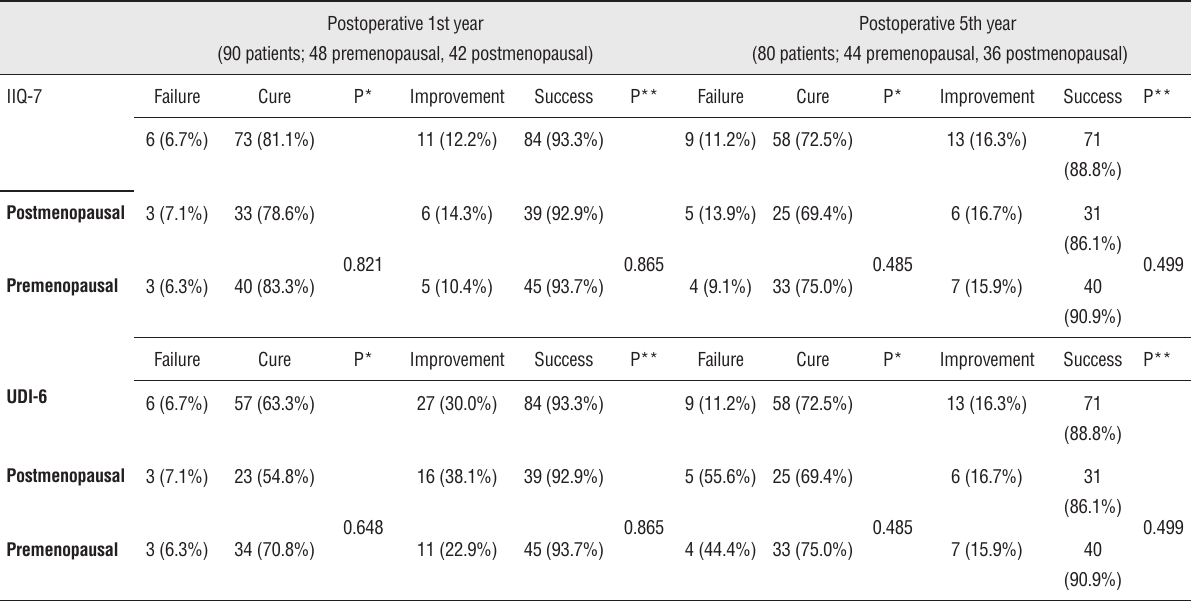
Table 1 - Comparison of the cure and success rates of postmenopausal and premenopausal groups in terms of the first-year and fifth-year outcomes according to IIQ7 and